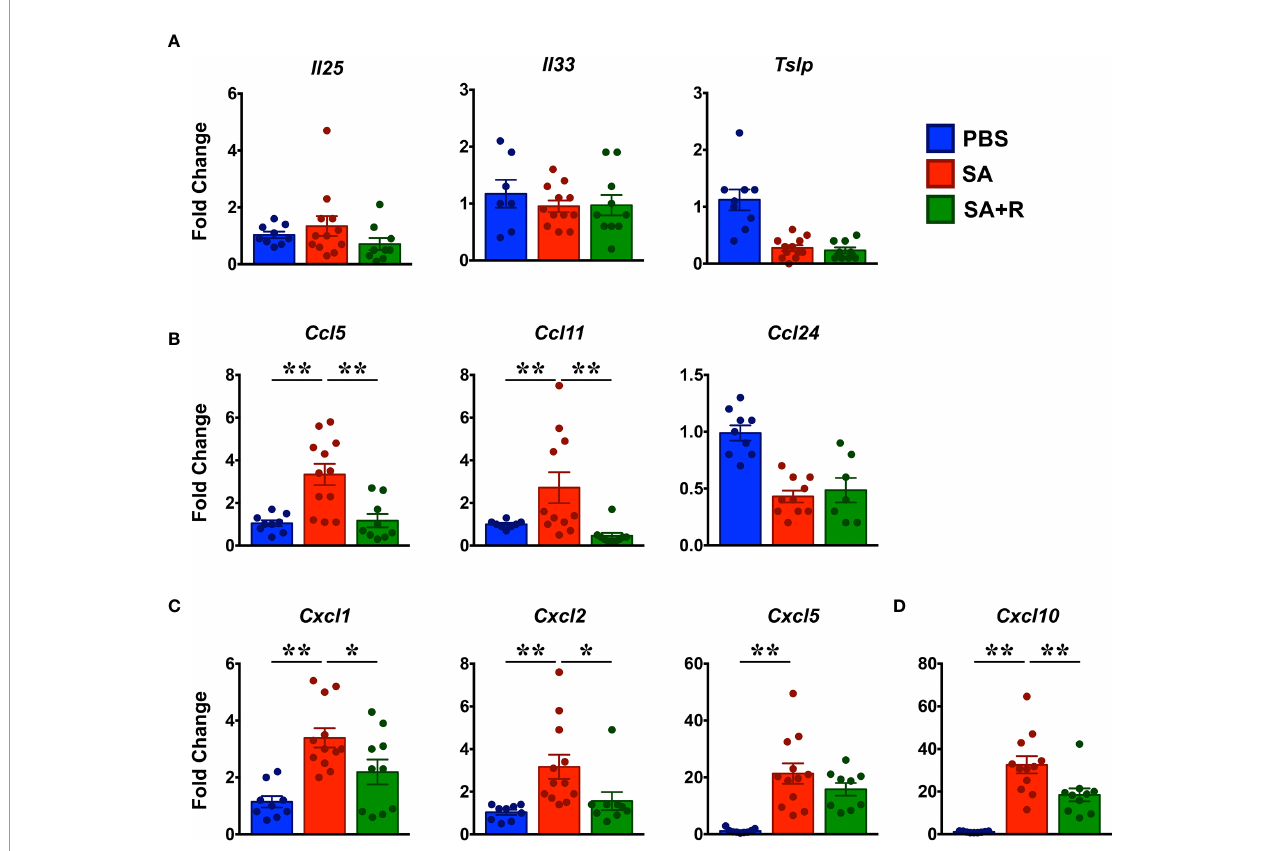
FIGURE 5 | Reduced chemokine expression in the lungs of Ruxolitinib-treated SA mice. (A – D) Lungs tissues of PBS-treated, SA and SA+R mice were analyzed for gene expression of (A) alarmins ( Il25 , Il33, Tslp ), and various eosinophilic (B) , neutrophilic (C) , and Th1 (D) chemokines by qPCR. Data is shown as mean fold change ± SEM and pooled from 3 independent experiments with a total of 8-12 mice per cohort. Statistical signi fi cance was determined by Student ’ s unpaired t test with Welch ’ s correction. *p ≤ 0.05, **p ≤